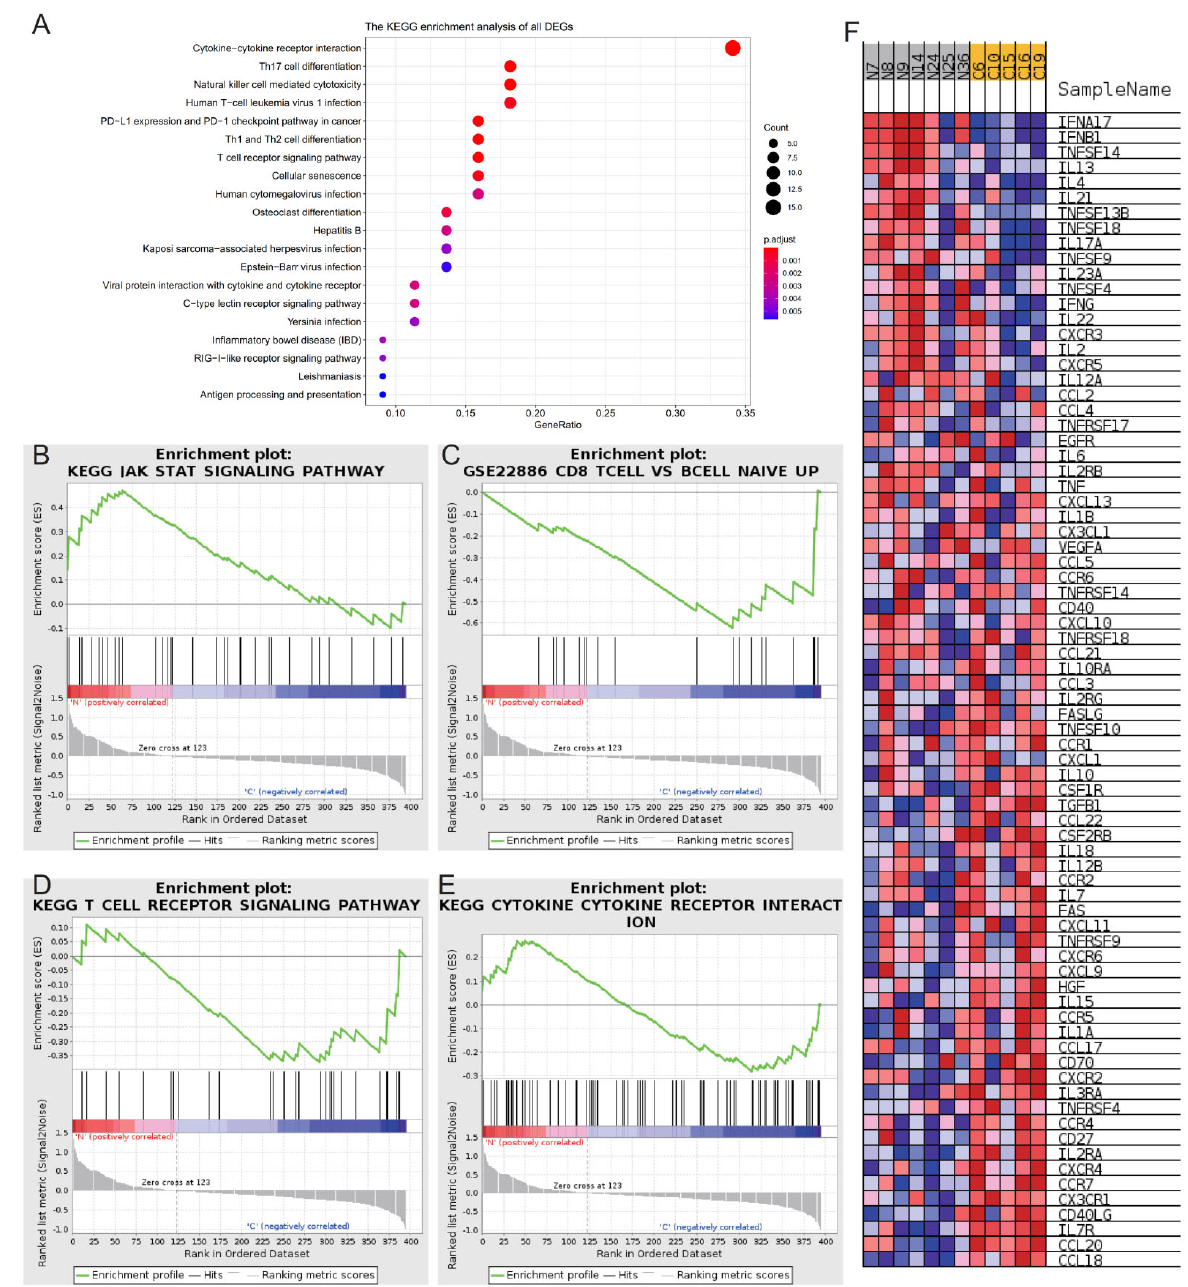
Figure 3. ( A ) KEGG analysis of DEGs in Group C and Group N. ( B – E ) GSEA of DEGs in Group C and Group N. ( F ) The pathway of CYTOKINE-CYTOKINE RECEPTOR INTERACTION contains a list of genes.